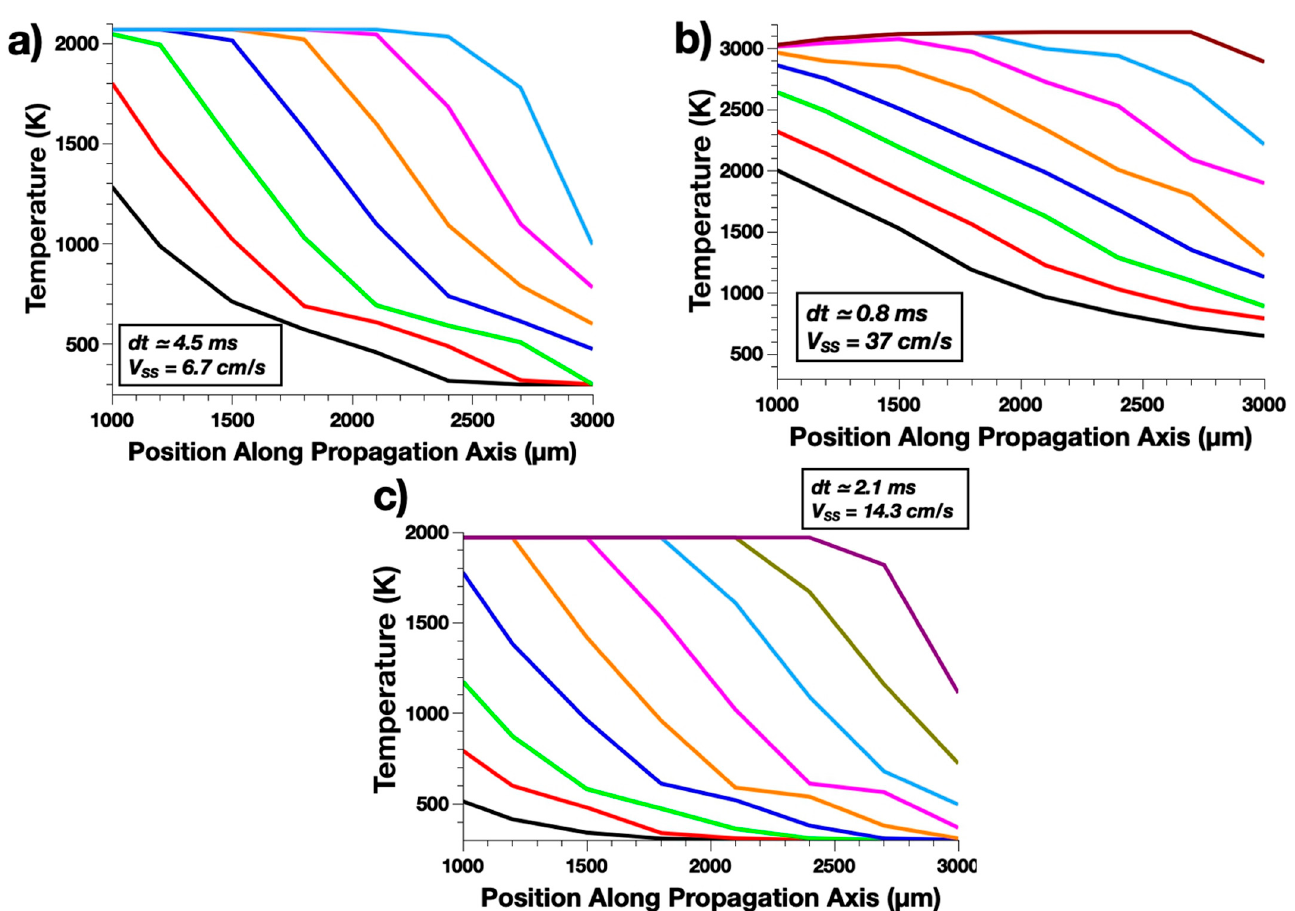
Figure 5. Temperature profiles taken at regular time intervals dt and calculated burn rate V SS for ( a ) Zr/CuO, ( b ) Zr/Fe 2 O 3 , and ( c ) Zr/WO 3 , systems at ξ = 1.0 with 80-nm Zr particles.